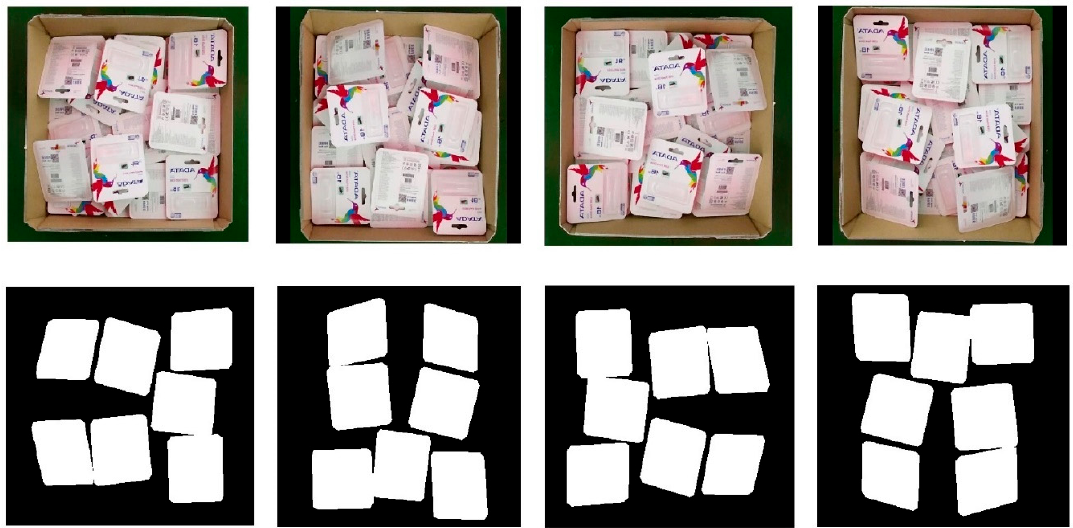
Figure 4. Top: Original image and three other versions after the original data passed through the augmentation module. Bottom: Corresponding binary image.